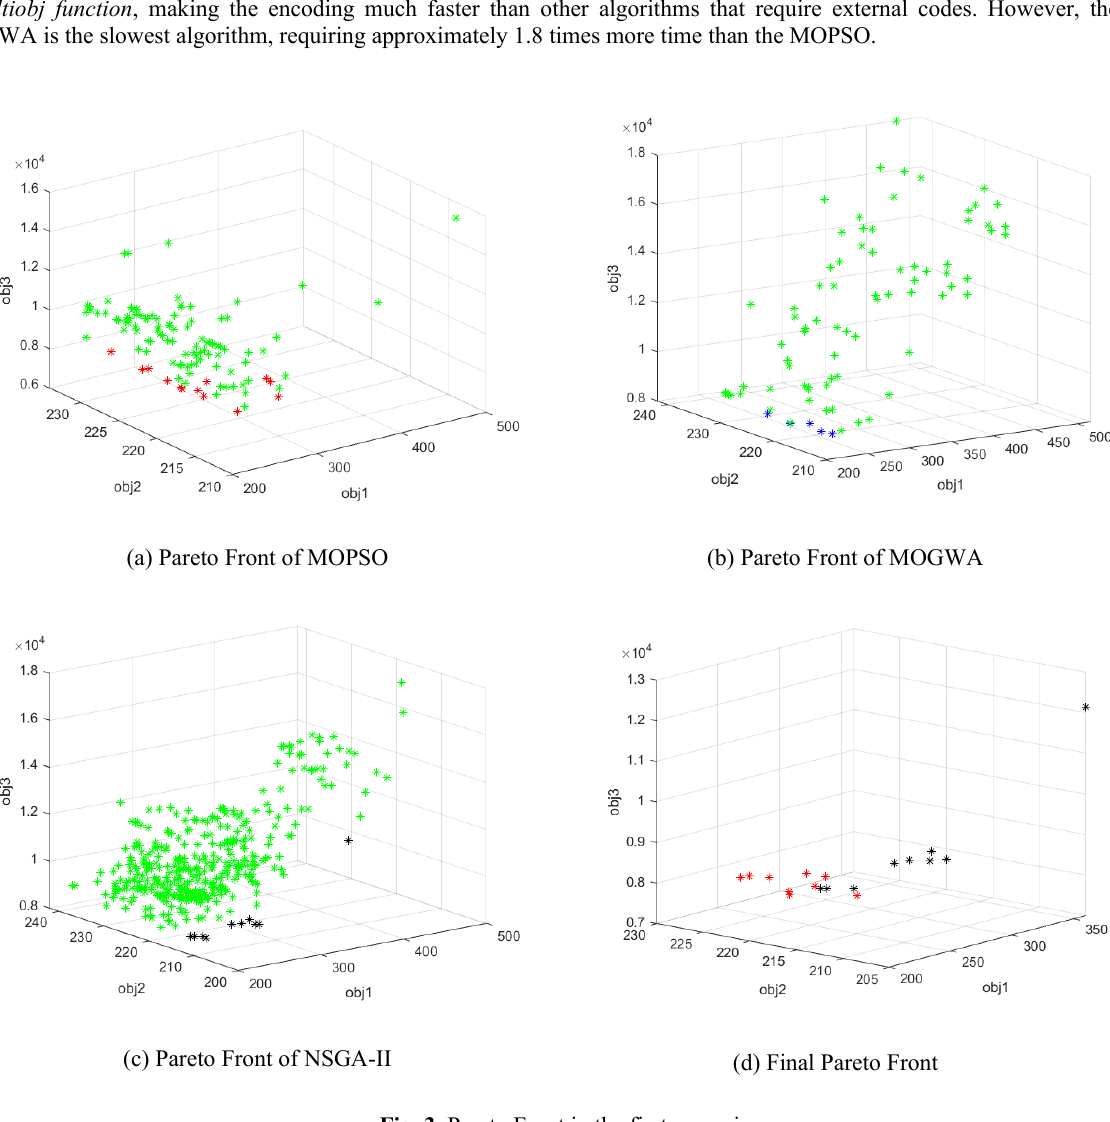
Fig. 3. Pareto Front in the first